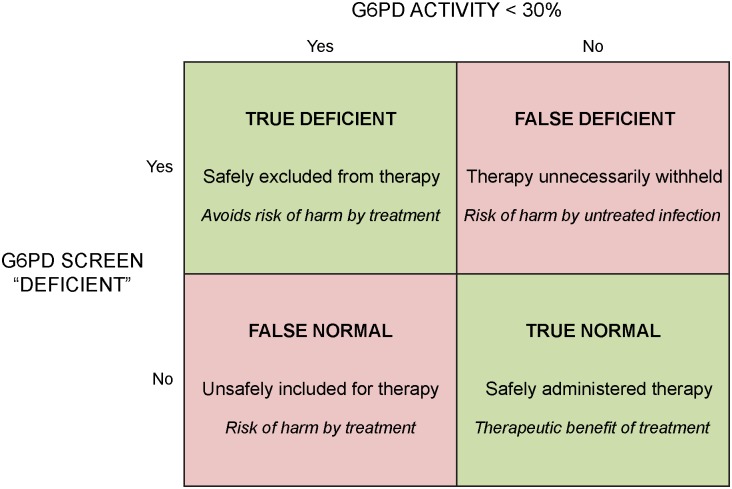
Chart illustrating the rationale for assessing diagnostic performance of qualitative G6PD screening devices in the context of a clinical decision to offer or withhold primaquine therapy in patients with P. vivax malaria.Each classification (bold font top), clinical outcome (normal font middle), and risk or benefit (italics bottom) of diagnostic performance appears in each box of classification.